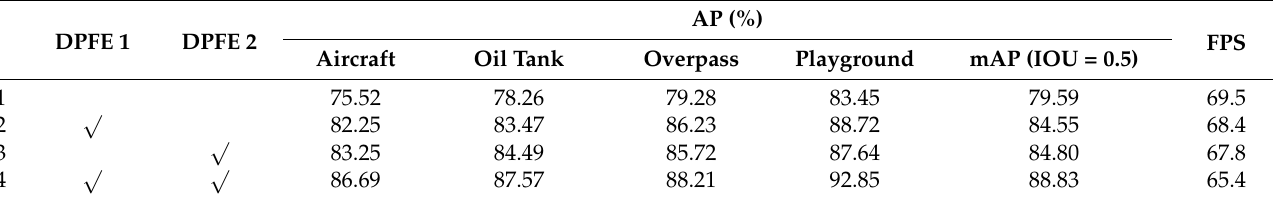
Table 12. The influence of DPFE modules on the RSOD dataset.